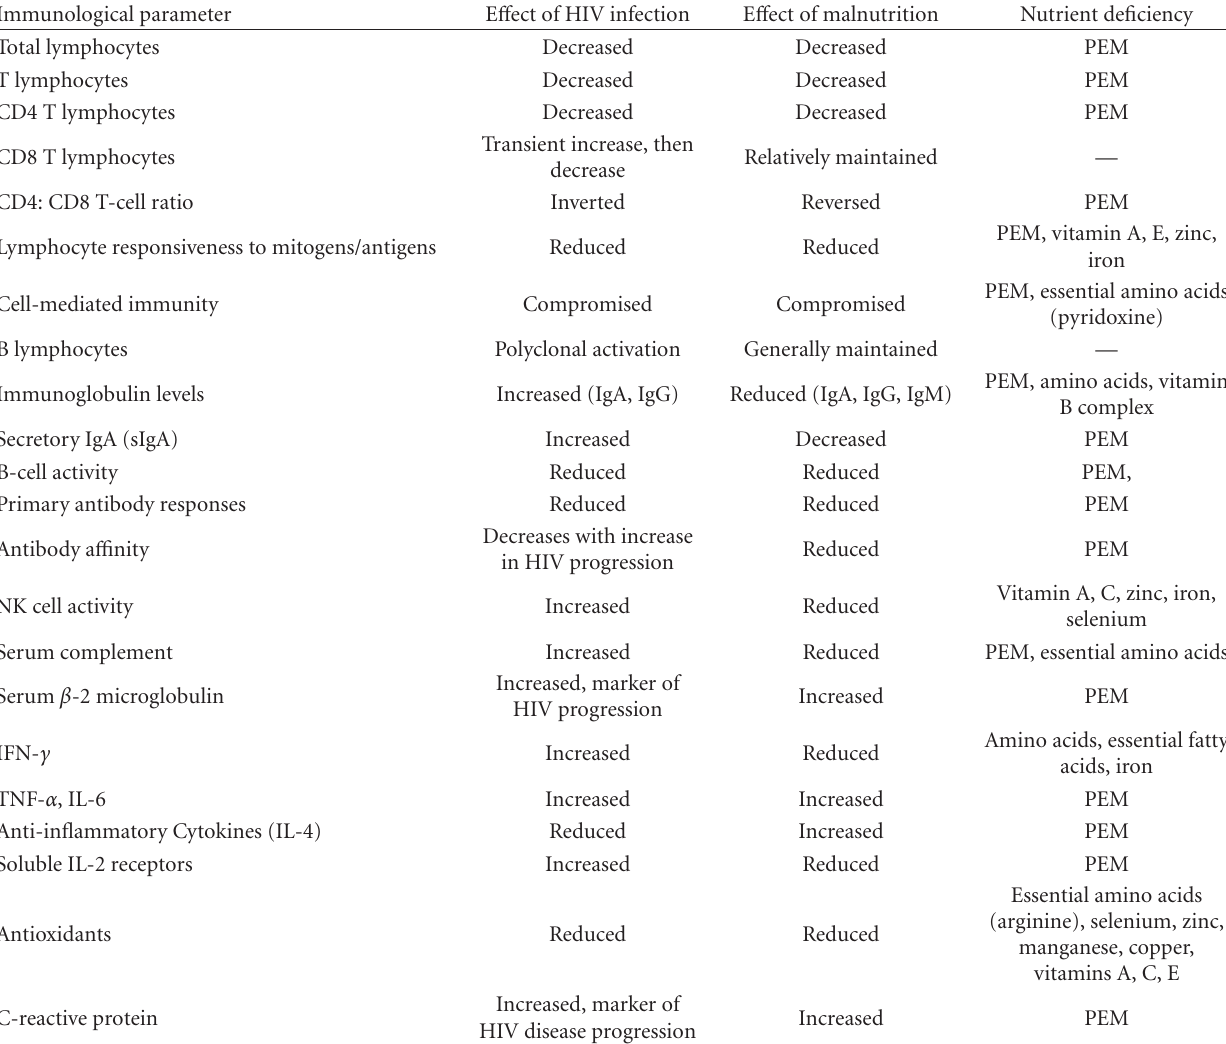
Table 1: Comparison of e ff ects of HIV infection and malnutrition on various parameters of the immune system [20, 24, 47,